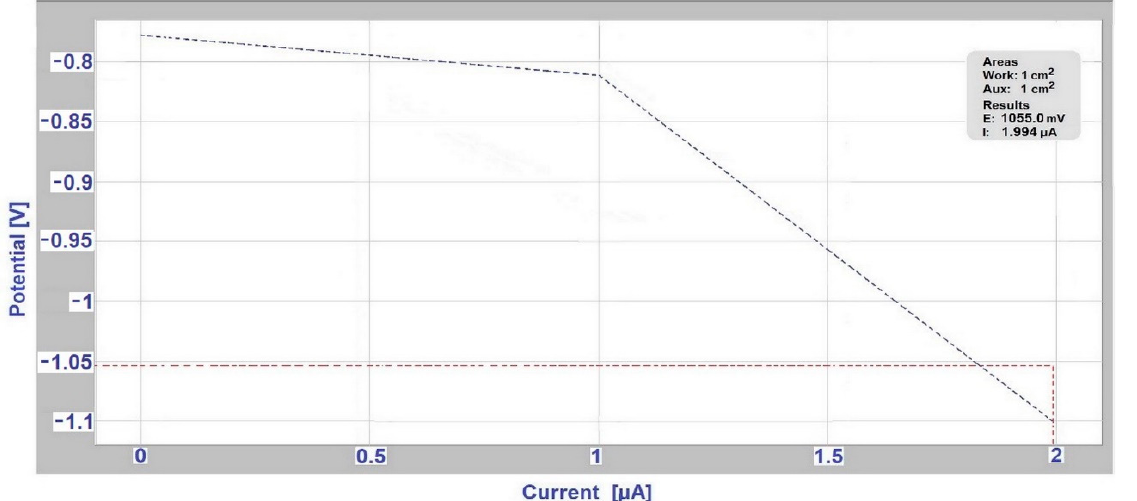
Figure 8. Evans diagram for hot-dip galvanized steel/EN AW-6060 couple (ratio of anode A and cathode A:C is 1:1) in deicing salt in the ninth week of measurement.